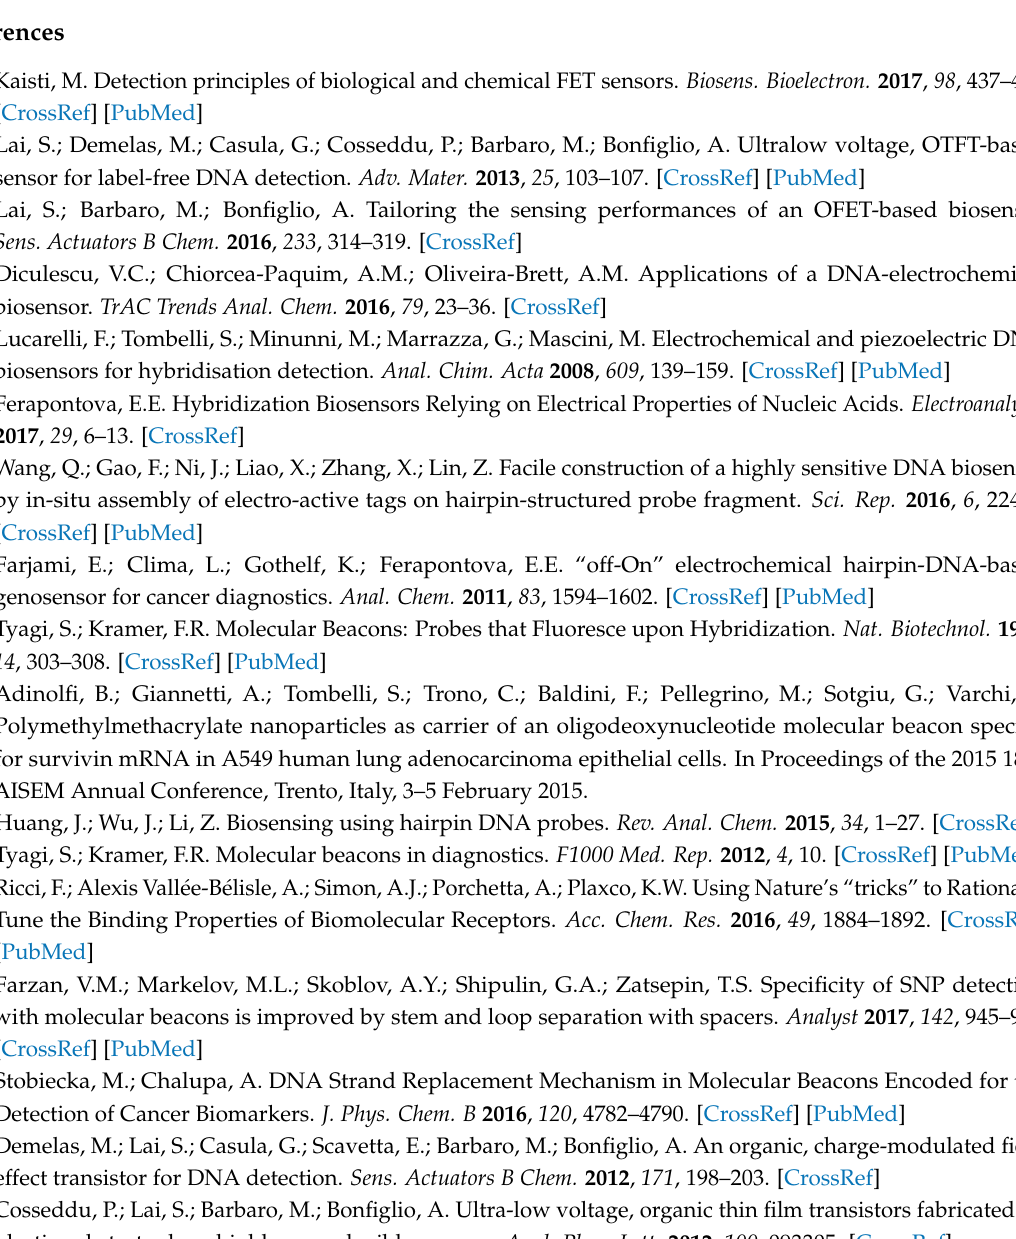
Figure S1: Electrical characterization of an OCMFET sensor; Table S1: Summary of electrical parameters of OCMFET